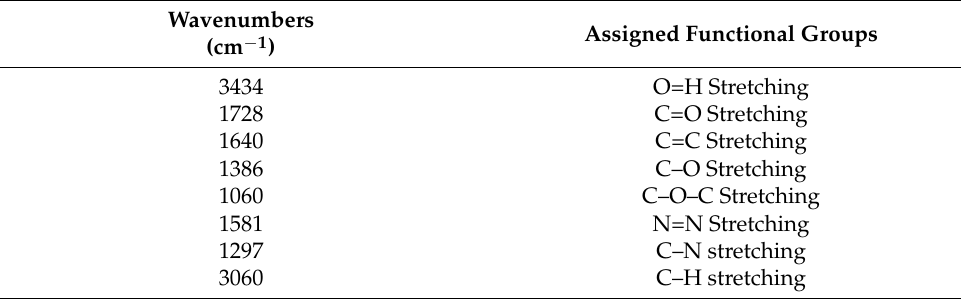
Table 2. Functional groups present in GD-AZO